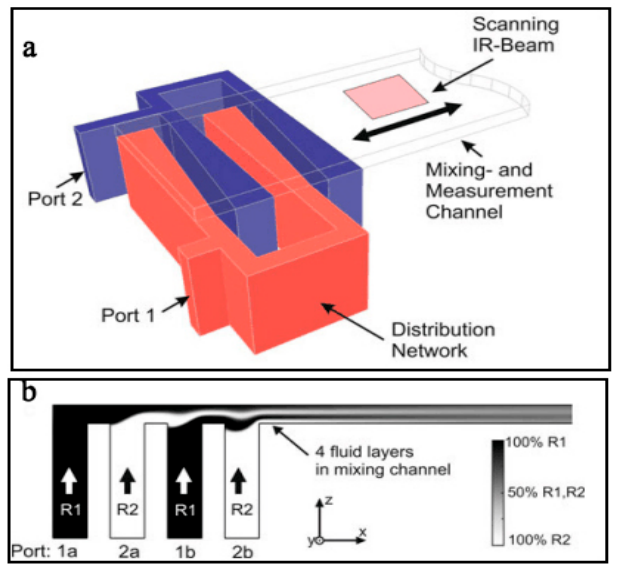
Figure 16. ( a ) Schematic of the lamination based micromixer with four lamination layers; ( b ) Two dimensional flow simulation of the micromixer. Reproduced with permission from [139]. micromixer (CMM) (Figure 17).